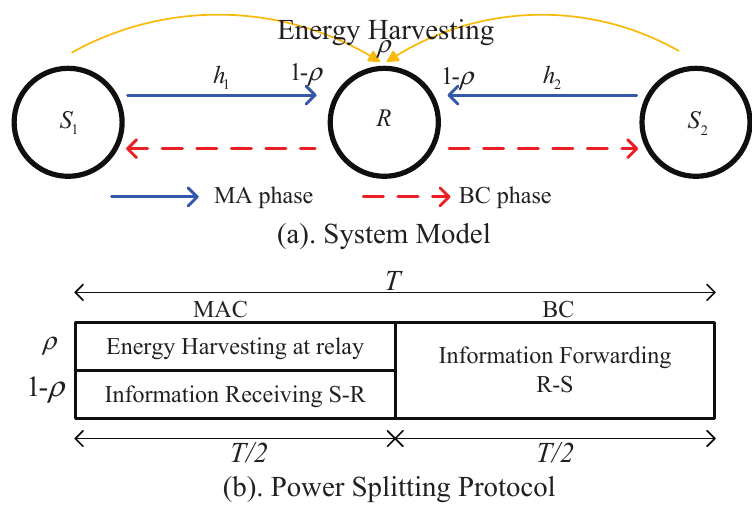
Figure 1. ( a ) System model ( b ) energy-harvesting